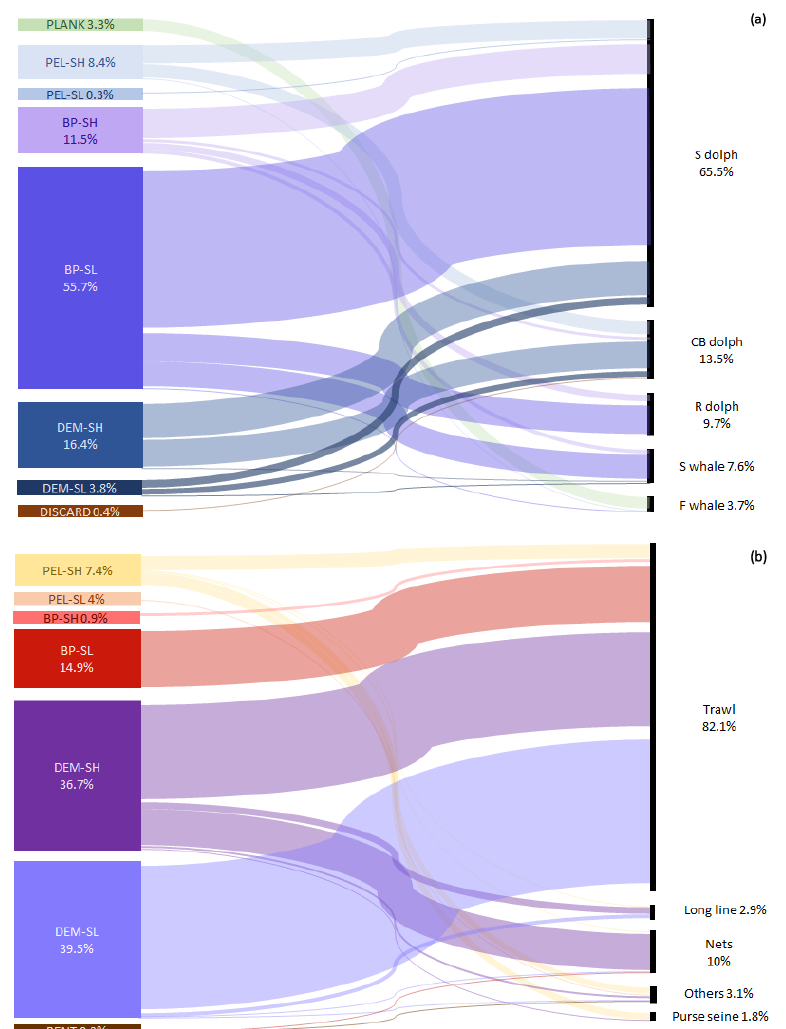
Figure 5. Sankey plots of ( a ) consumption flows towards cetaceans; ( b ) catches of types of fishing gear by FGs both aggregated into ecological domains: Planktonic (PLANK), Pelagics groups of shelf (PEL-SH), Pelagics groups of slope (PEL-SL), Demersal groups of shelf (DEM-SH), Demersal groups of slope (DEM-SL), Benthopelagic groups of shelf (BP-SH), Benthopelagic groups of slope (BP-SL), and Discards.